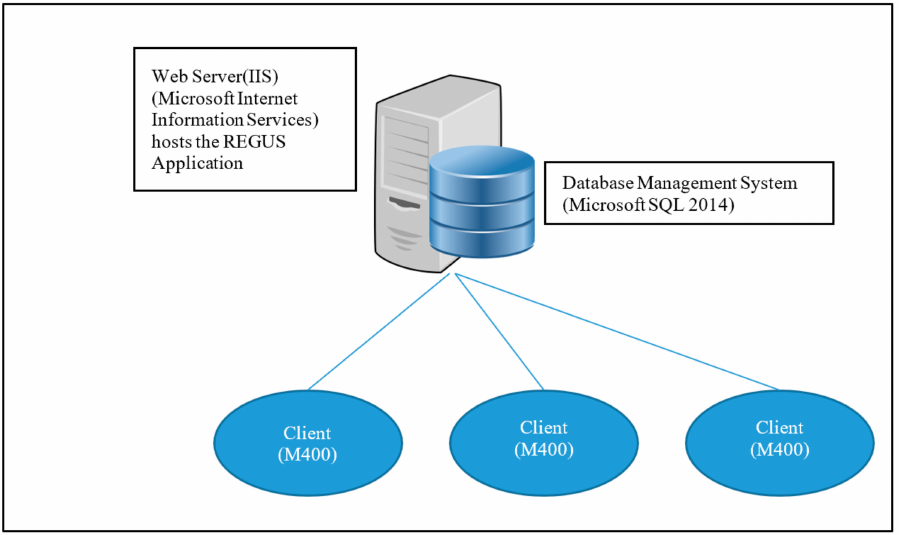
Figure 11. Simple Object Access Protocol (SOAP) was used in Daedalus for client—server